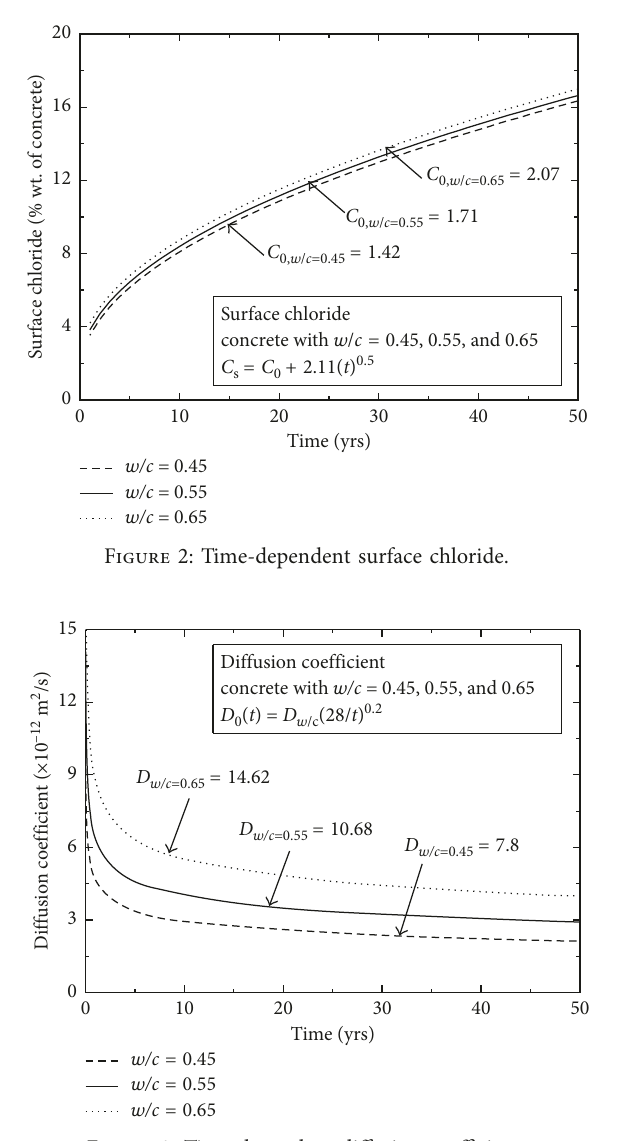
Figure 3: Time-dependent diffusion coefficient.